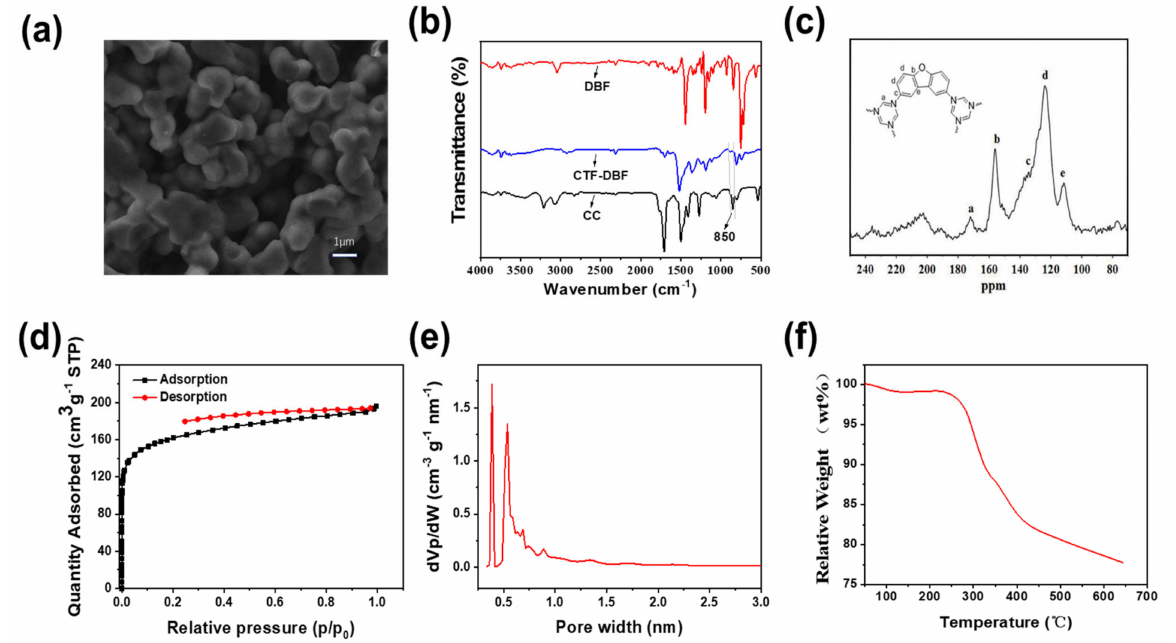
Figure 3. Characterization of CTF-DBF: ( a ) SEM; ( b )FT-IR; ( c ) Solid-state 13 C NMR; ( d ) N 2 adsorption- desorption isotherms; ( e ) Pore size distribution; ( f )